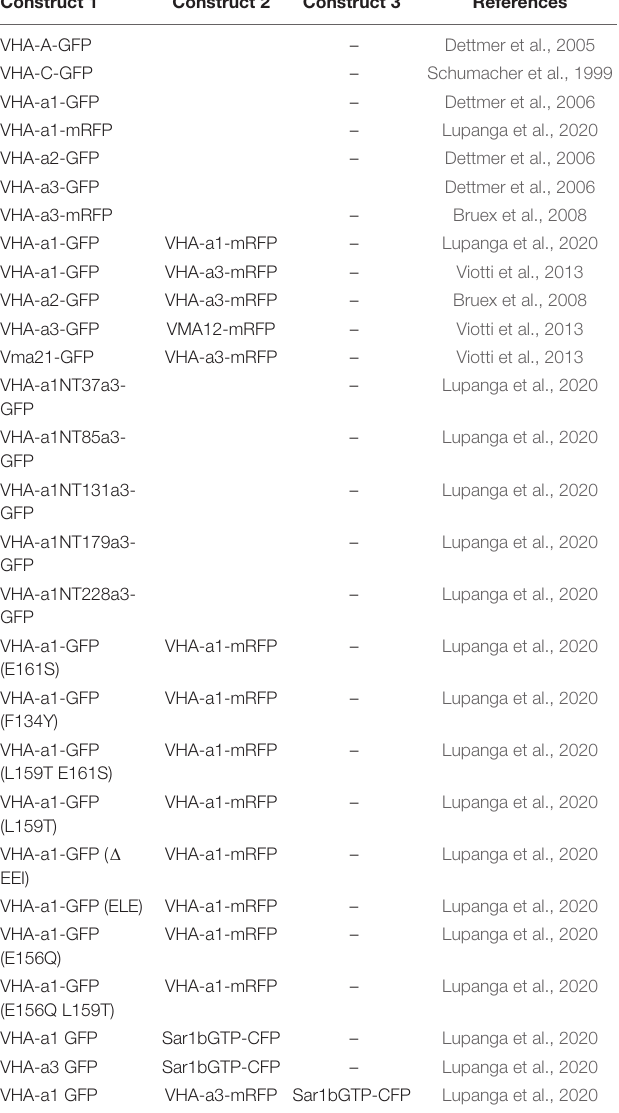
TABLE 2 | Fluorescent protein reporter lines.